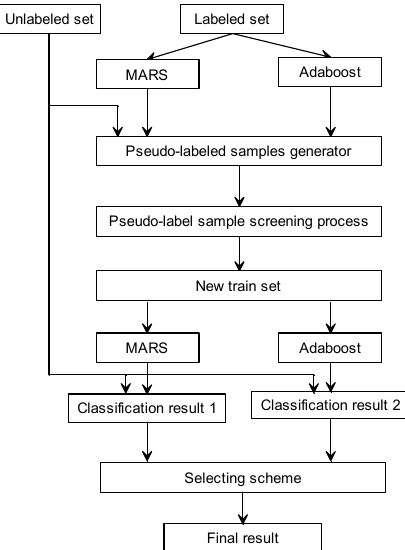
Figure 1. Overview of the semi-supervised neighbor ensemble learning method (SSNEL).